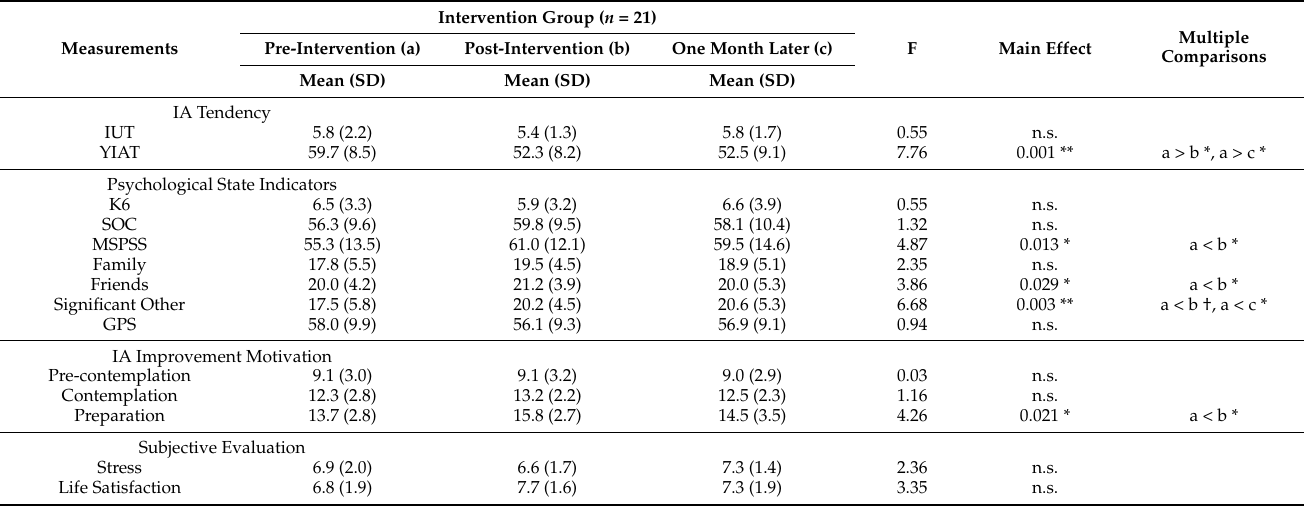
Table 4. Results of Follow-up Effectiveness Evaluation of Intervention Group ( n = 21).